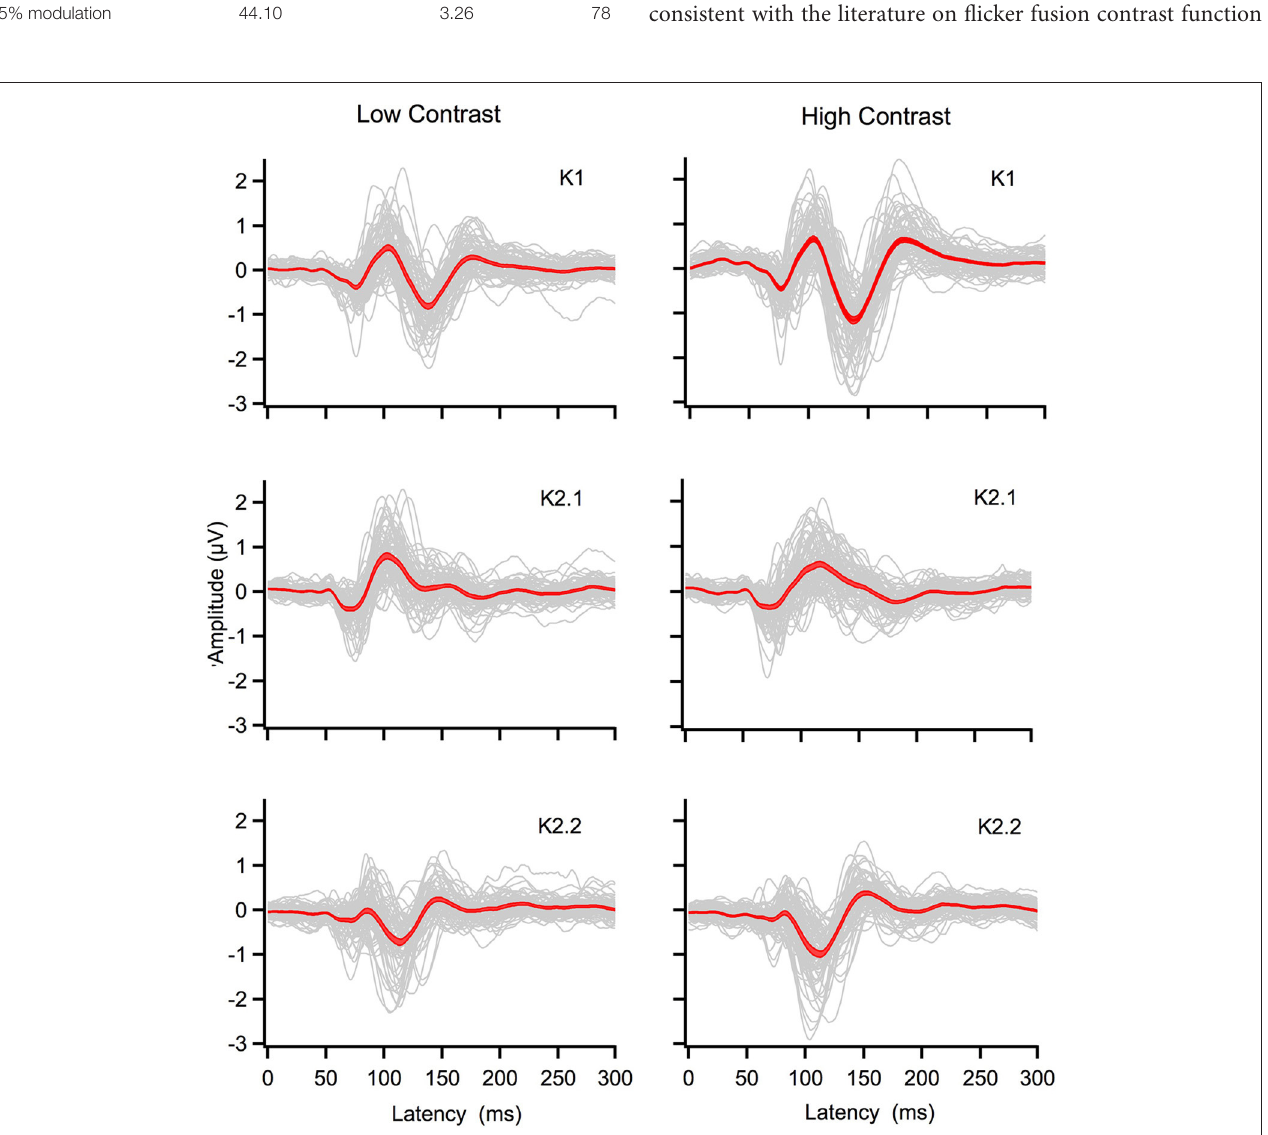
FIGURE 2 | Individual (gray) and grand mean averages with standard errors (red) for the first and second order kernel responses generated by the central patch of the multifocal stimulus. The left column shows K1, K2.1, K2.2 responses for low contrast (24%) while the right column shows responses for high contrast (96%).